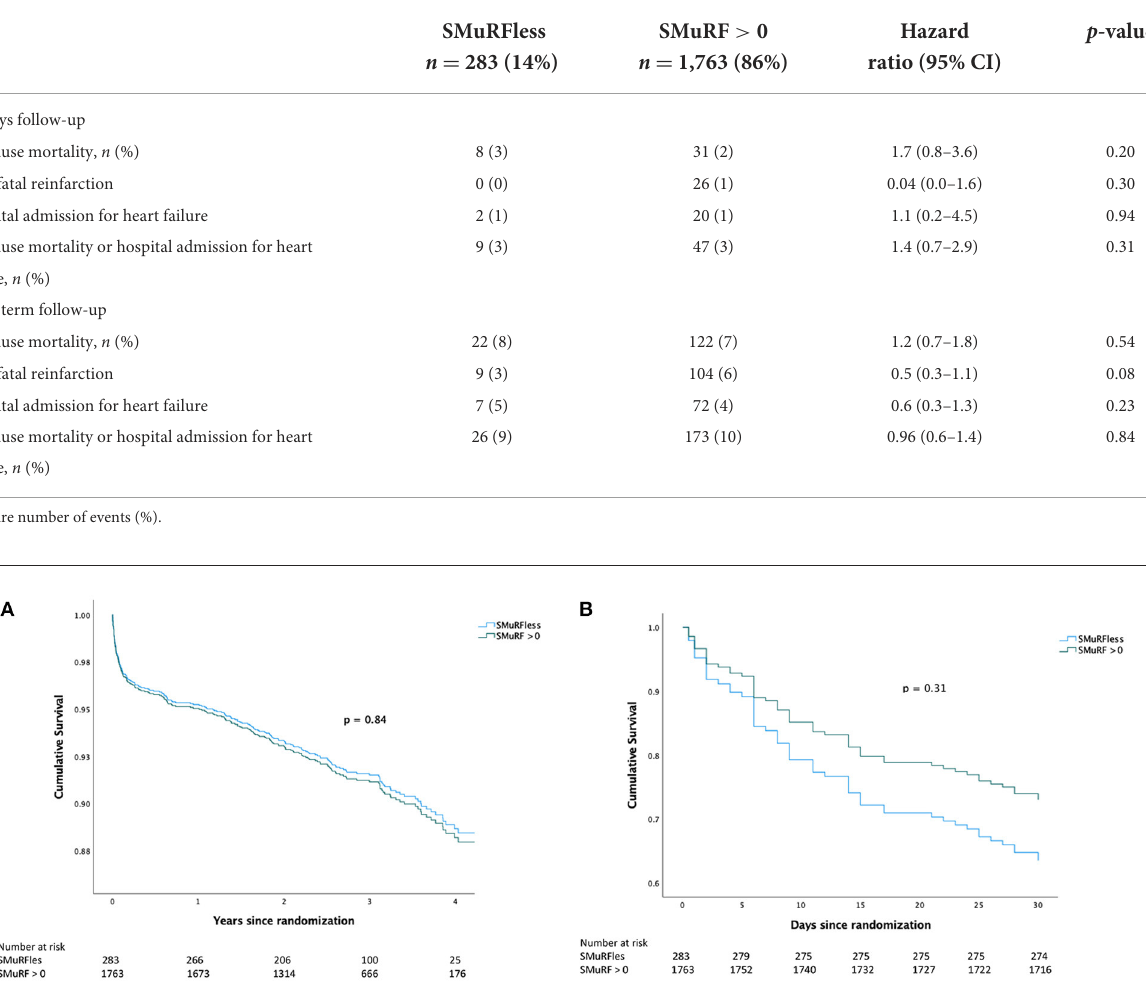
disease between SMuRFs and SMuRFless patients (39 vs. 42%, p =